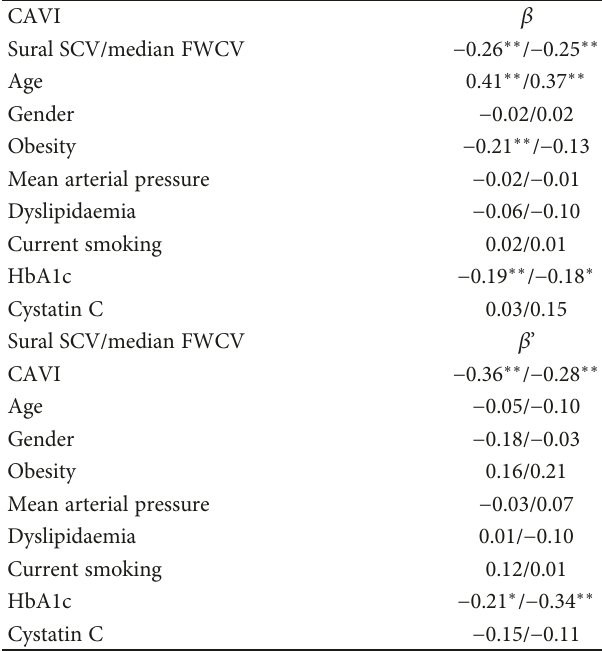
Table 2: Clinical pro fi le of the CAVI and DPN markers ( n = 166 ). CAVI